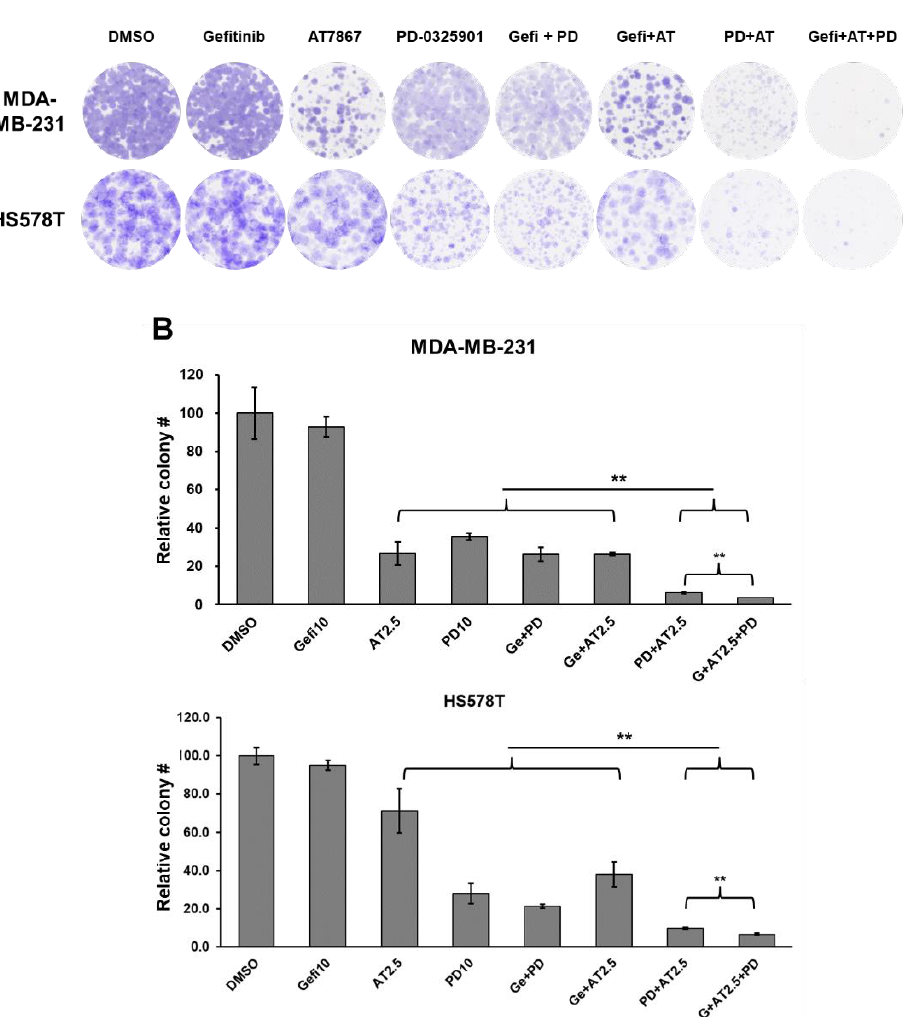
Figure 8. Reduced colony formation of MSL TNBC cells treated with gefitinib andAT7867 and PD-0326901. ( A ) Representative images of the colonies; cells were treated with 10 μM of gefitinib, 2.5 μM of AT7867, and 10 μM of PD-0325901, or other drug combinations (as indicated) for 24 h and further cultivated for 10–14 days to form colonies in normal growth media. The surviving colonies were stained and scanned using an image scanner. Three independent experiments were performed in triplicate and representative images are shown. ( B ) Relative colony numbers were determined and presented as mean ± SEM. ** p < 0.01.